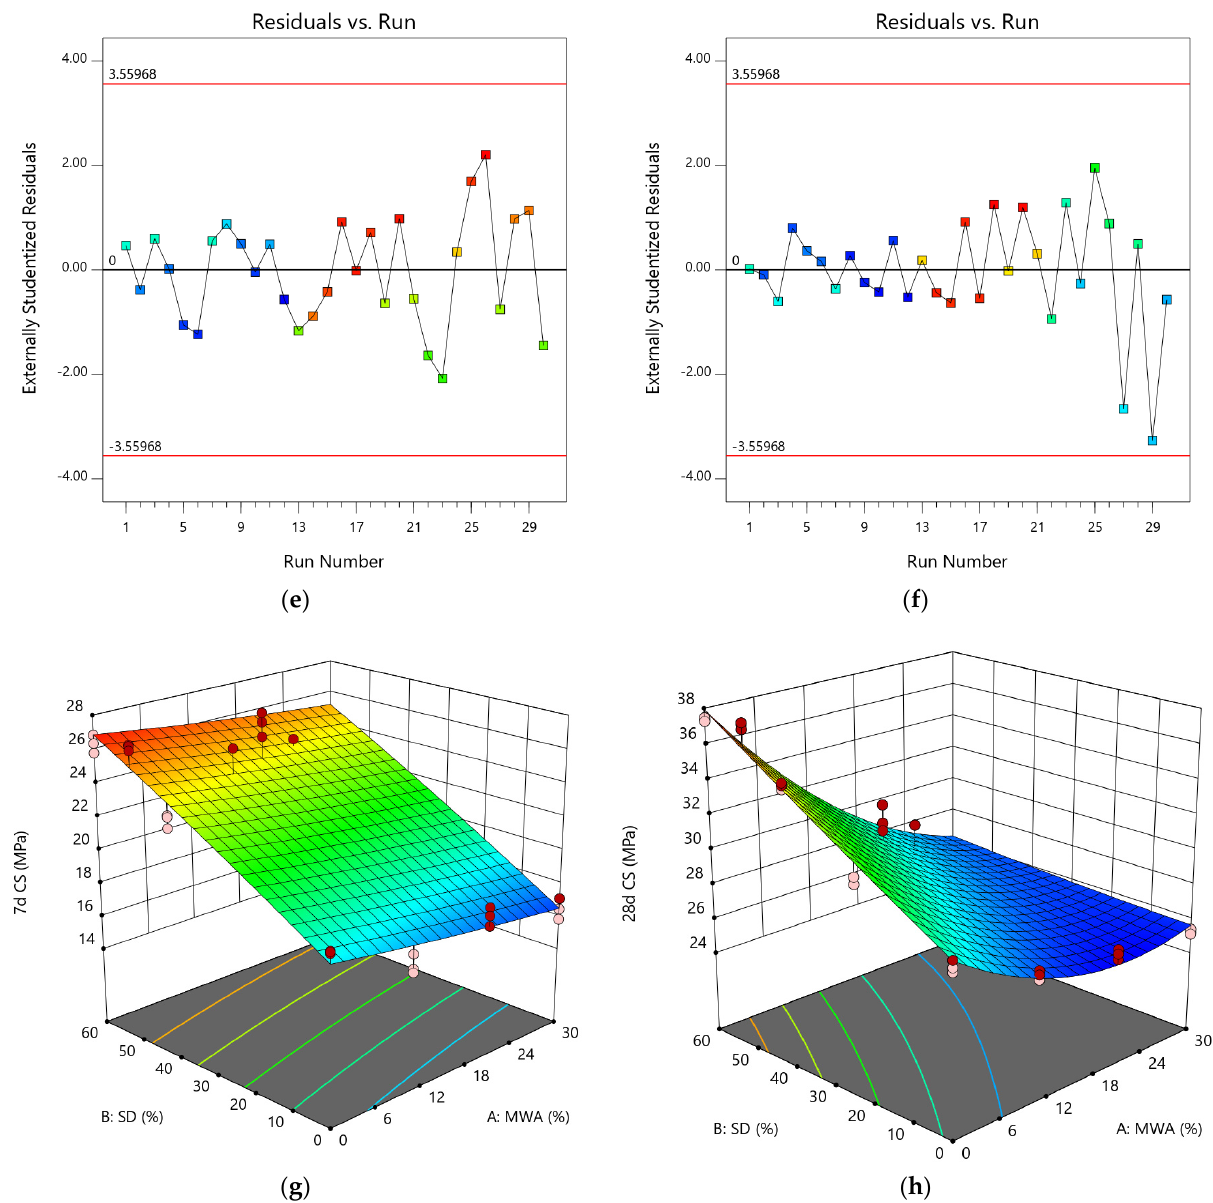
Figure 7. Diagnostic and 3D plots of compressive strengths at 7 days and 28 days. ( a ) 7-day com- pressive strength, ( b ) 28-day compressive strength, ( c ) 7-day compressive strength, ( d ) 28-day compressive strength, ( e ) 7-day compressive strength, ( f ) 28-day compressive strength, ( g ) 7-day compressive strength, ( h ) 28-day compressive strength.